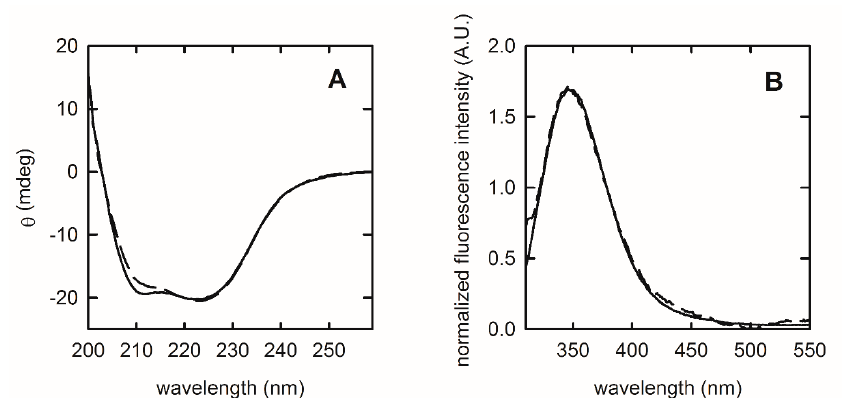
Figure 1. Structural characterization of entrapped puuE (solid lines) in comparison to the free enzyme (dashed lines) in 20 mM potassium phosphate, pH 7.4. ( A ) Normalized far-UV circular dichroism spectra; ( B ) normalized tryptophan emission spectra upon excitation at 298 nm.